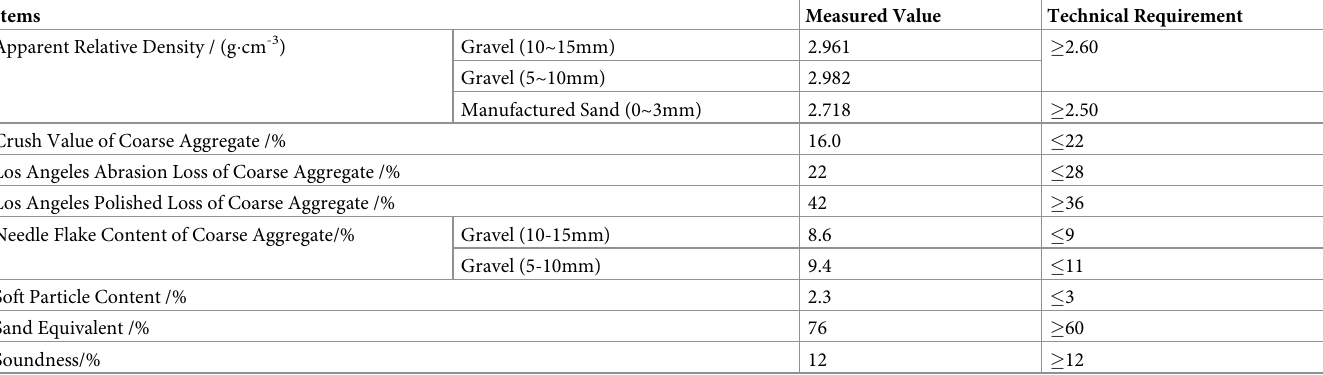
Table 5. The main technical performance of the aggregate used.